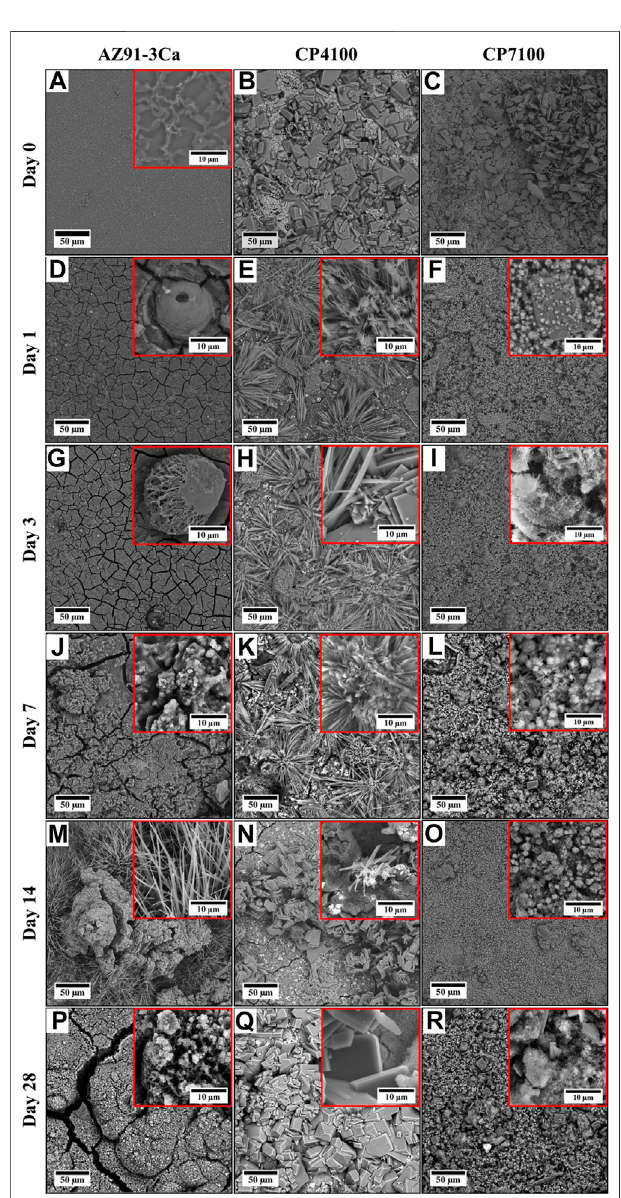
FIGURE 3 | SEM micrographs of coated and uncoated AZ91-3Ca alloy before and after immersion in